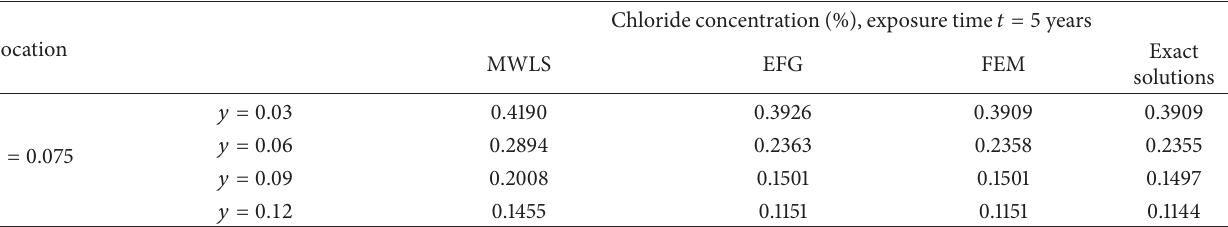
Table 4: Comparison of MWLS results with EFG, FEM, exact solutions at the specified locations ( 𝑥,𝑦 ).